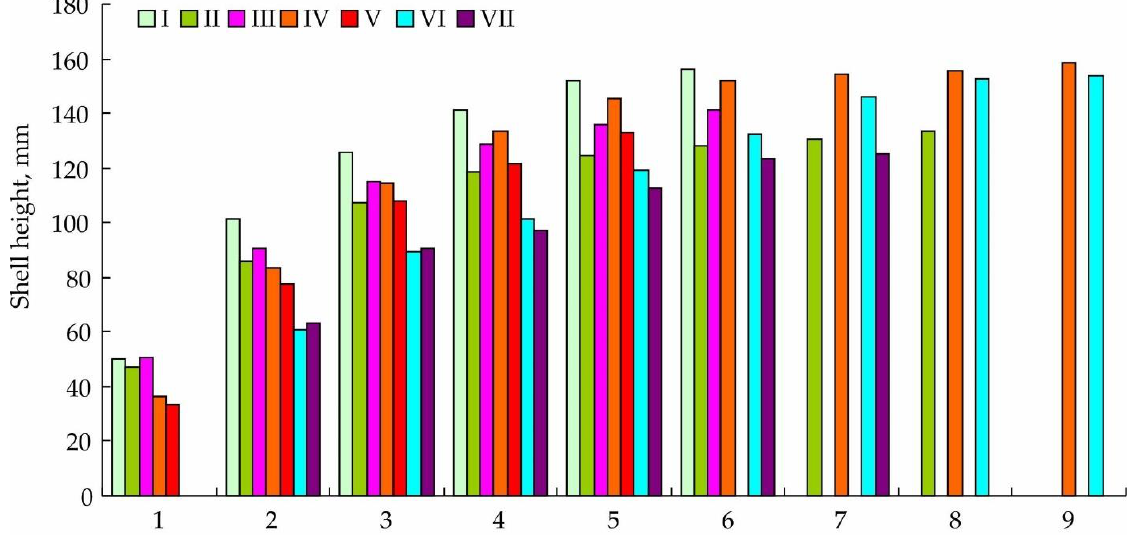
Figure 2. Age of different-sized Mizuhopecten yessoensis in Russian waters of the Sea of Japan (modified from [42,43]). I — Furugelm Island (42°30 ′ N, 130°56′ E) , II — Andreev Inlet ( 43°06′ N, 132°19′ E) , III — Putyatin Island ( 42°51′ N, 132°25′ E) , IV — Olga Bay ( 43°42′ N, 135°15′ E) , V — Vladimir Bay ( 43°55′ N, 135°29′ E) , VI — Sovetskaya Gavan Bay ( 48°58′ N, 140°18′ E) , VII — Chikhachev Bay ( 51°27′ N, 140°50′ E) .